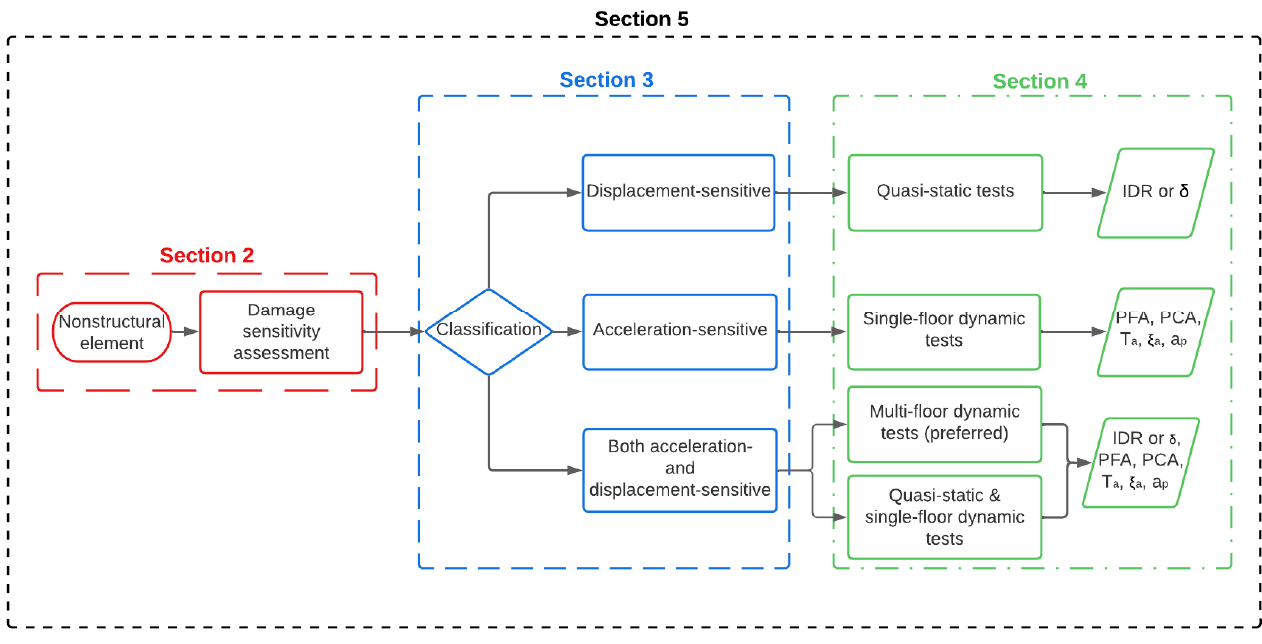
Figure 2. Outline of the paper and flowchart of the